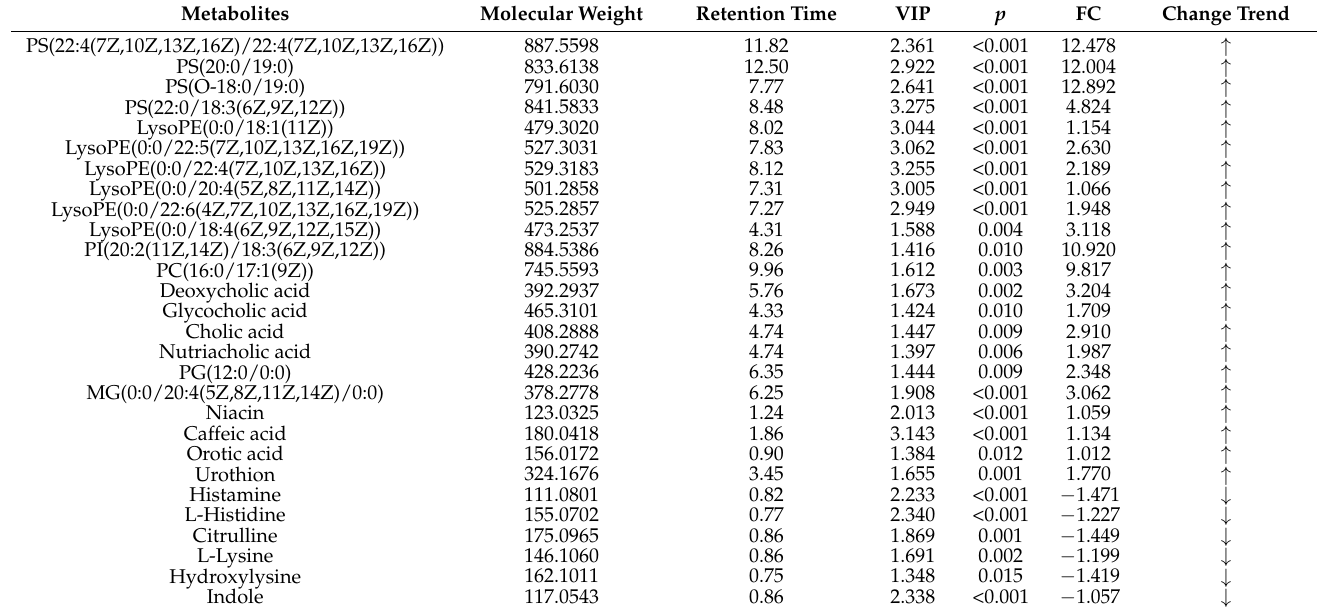
Table 3. Characteristic metabolites of the centenarians from the longevous region.